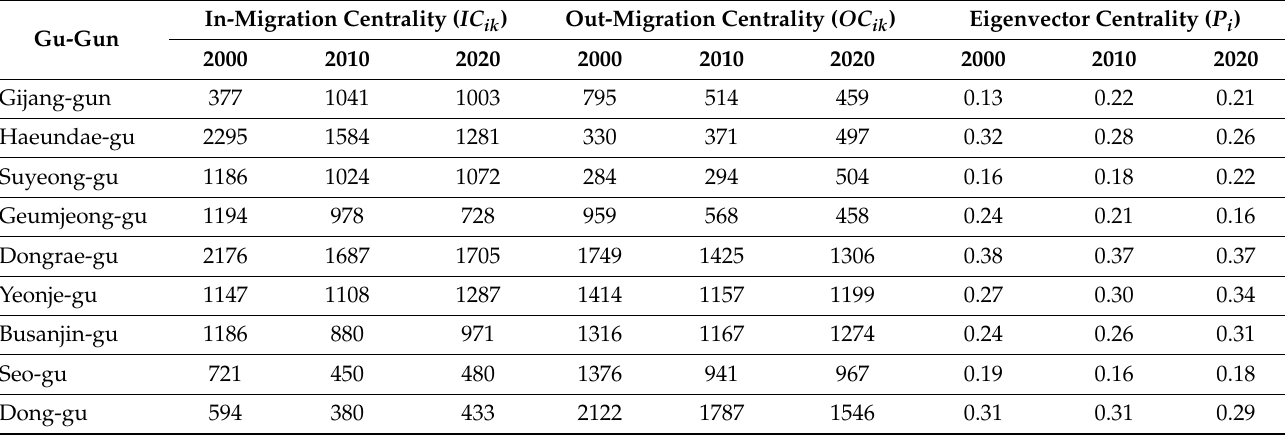
migration affected Dongrae-gu and Yeonje-gu. The eigenvector centrality, while not high, steadily increased for Gijang-gun and Gangseo-gu due to in-migration. Table 4. In-migration centrality, out-migration centrality, and eigenvector centrality. In-Migration Centrality ( IC ik Gu-Gun